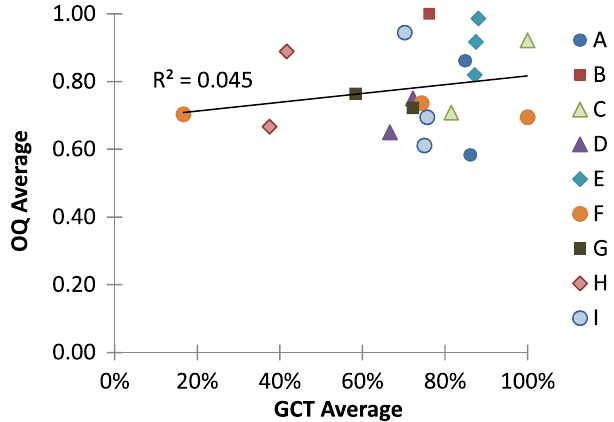
FIG. 3. Student performance on OQ vs GCT, averaged across all comparison questions, with linear regression and correspond- ing Pearson correlation coefficient ( R 2 ¼ 0 . 045 ). Error bars are not shown on the plot for clarity; the average standard error was (cid:2) 5% for the GCT and (cid:2) 0 . 03 for the OQ.